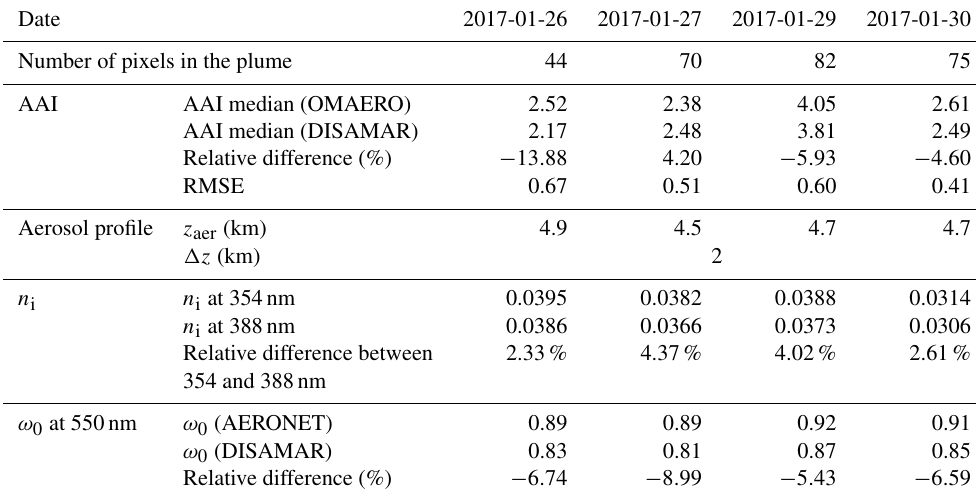
Table 2. Summary of retrieved results (after applying IQR outlier detection). The date format is